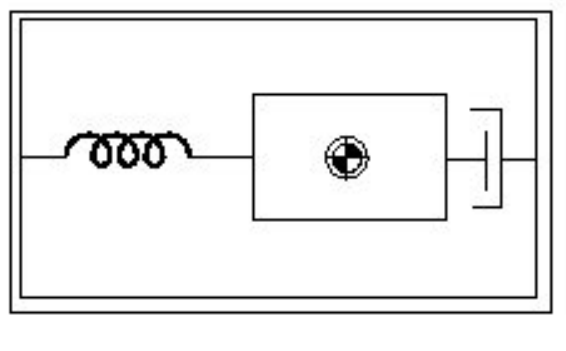
Figure 1. Basic spring-mass system: spring, test mass or seismic mass, and